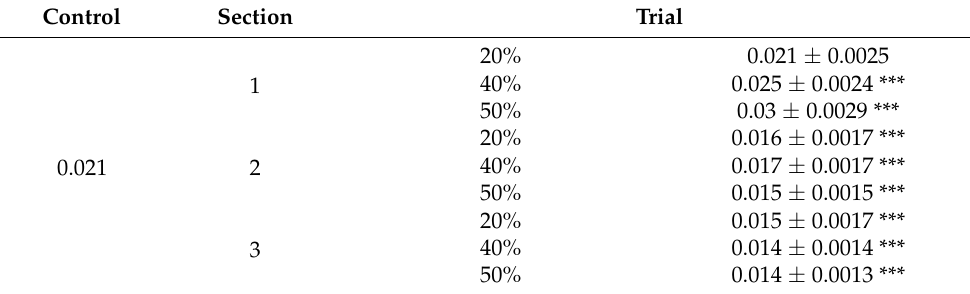
Table 1. Statistical significance test results of absolute average analysis for all Sections and degrees of obstruction compared to flow rate control conditions.